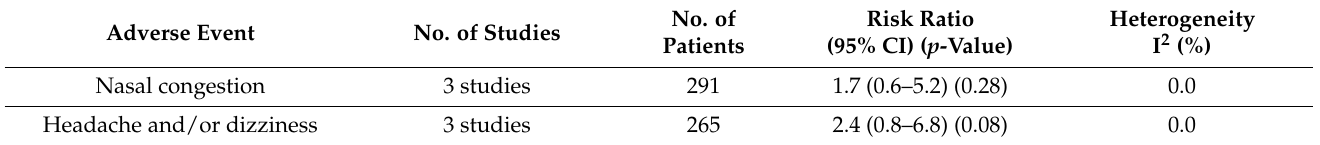
Table 4. Pooled risk ratios for subgroups of adverse